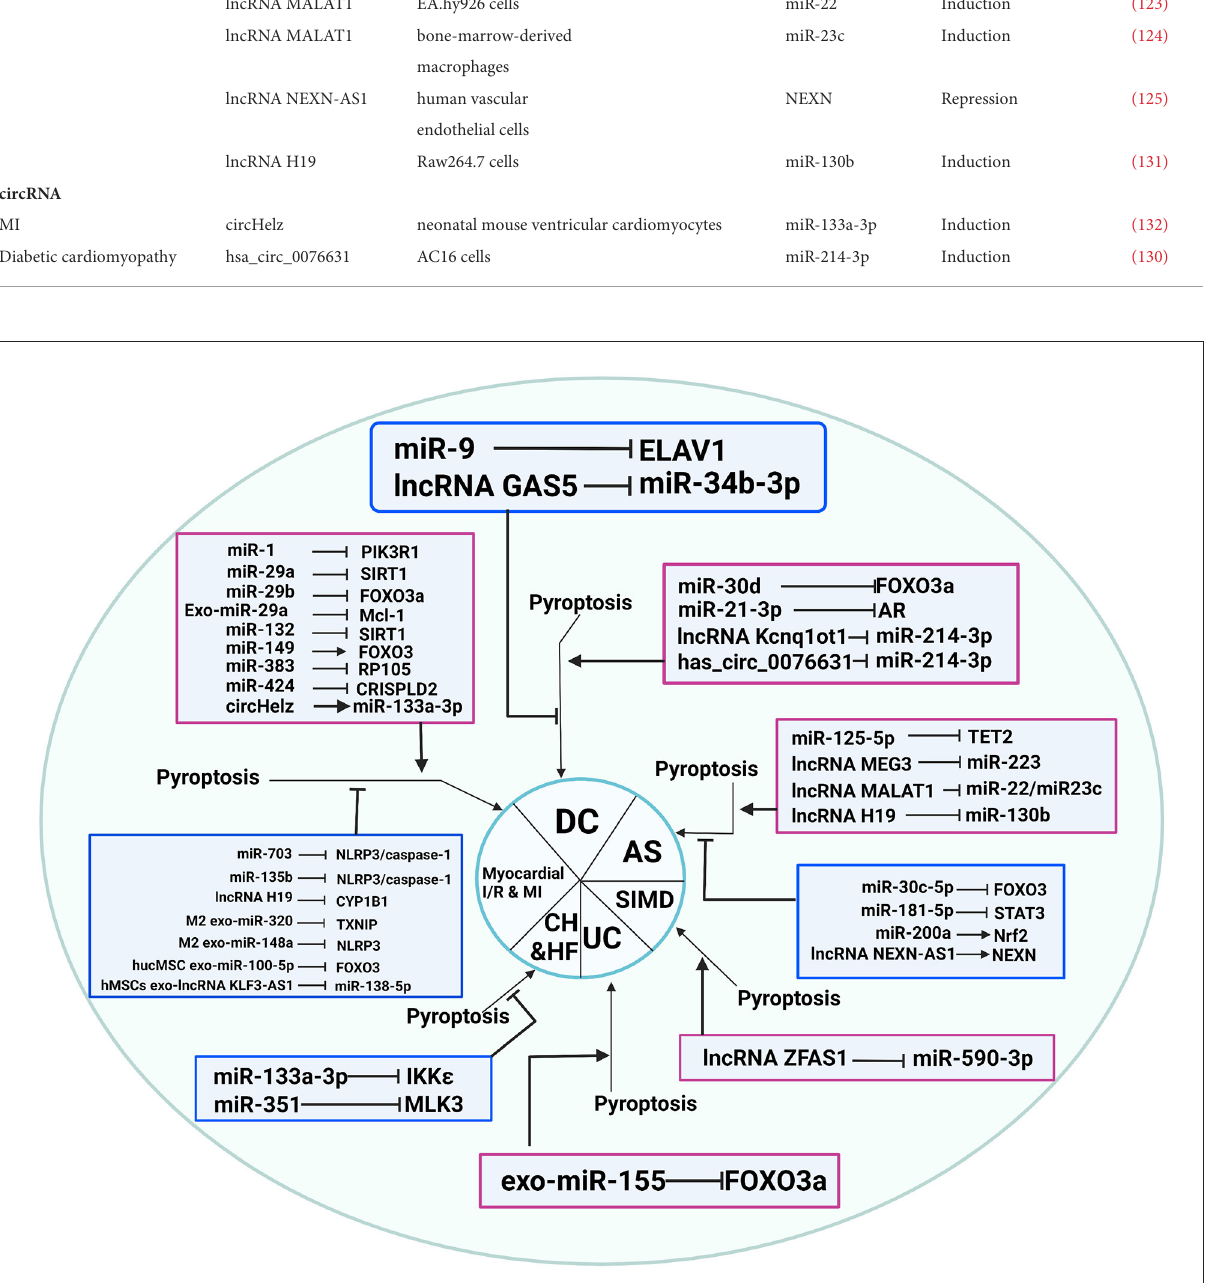
FIGURE3 Non-coding RNAs play an essential role in CVDs through pyroptosis regulation. AS, atherosclerosis; CH, cardiac hypertrophy; DC, diabetic cardiomyopathy; HF, heart failure; I/R, ischemia-reperfusion; SIMD, sepsis-induced myocardial dysfunction; UC: uremic